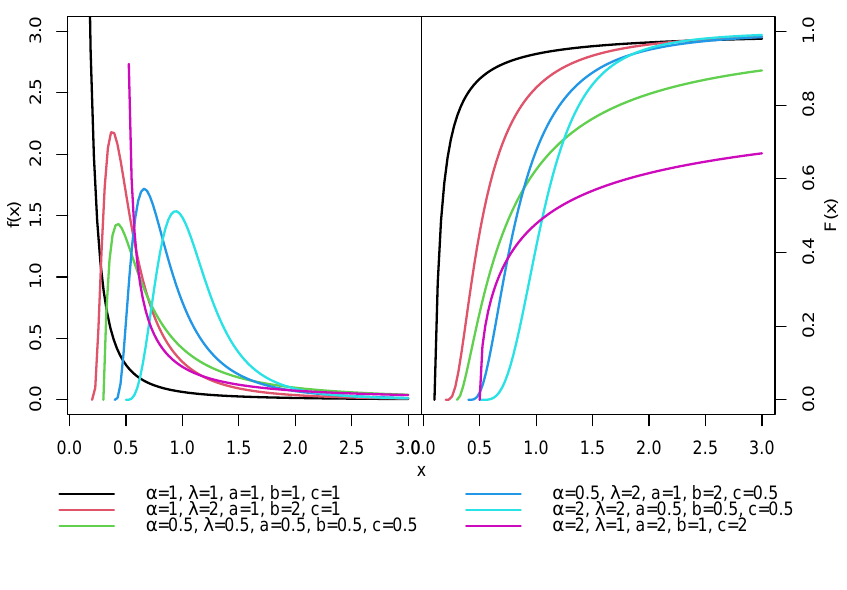
Figure 3 – PDF (left panel) and CDF (right panel) of McPaP